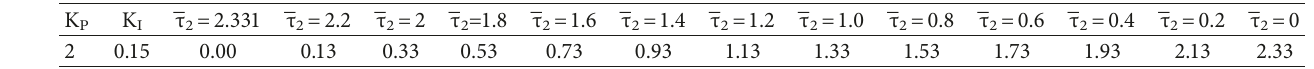
− 1, the highest acceptable delay bound τ ̅ 2